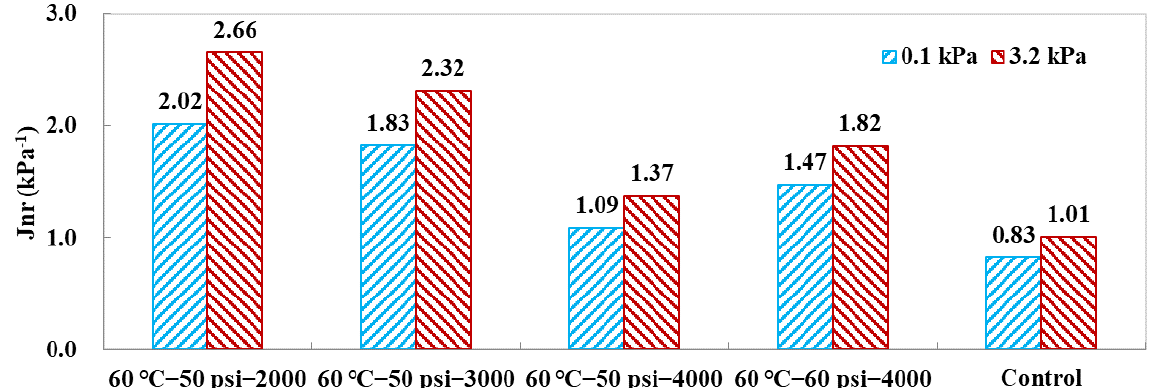
Figure 8. Variation of unrecoverable creep compliance Jnr in MSCR tests.